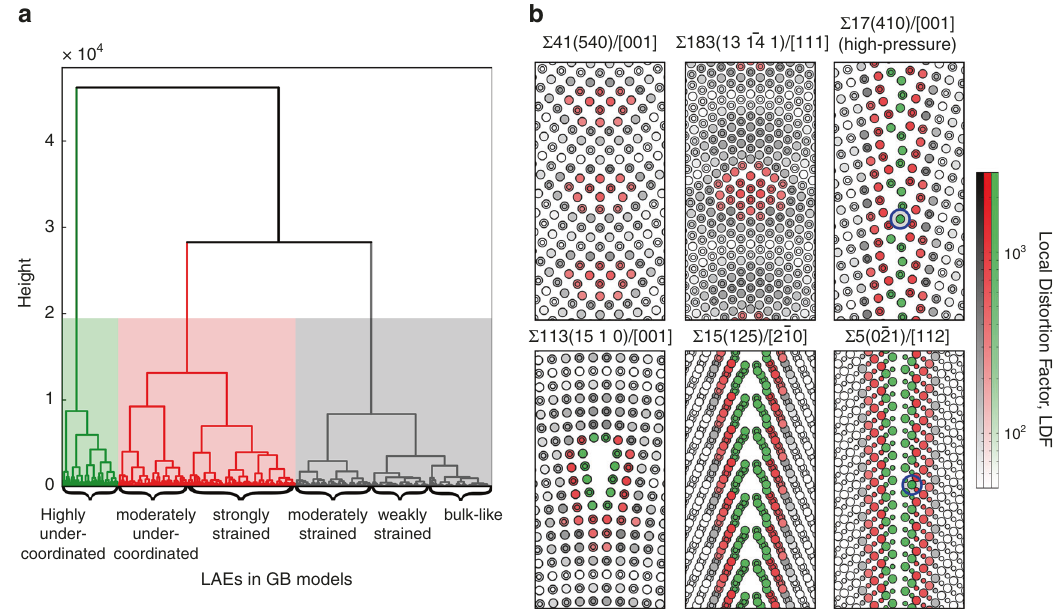
Fig. 3 Hierarchical clustering of GB LAEs. a Hierarchical relationship between LAEs depicted in dendrogram form. The different regions represent three general groups of LAEs: (green) highly under-coordinated (bond-ruptured); (red) moderately under-coordinated or strongly strained; and (grey) moderately strained, weakly strained or bulk-like. b Representative distributions of the LAE groups and LDFs at six STGBs. A log scale is used to make it easier to distinguish changes in LDFs within LAE